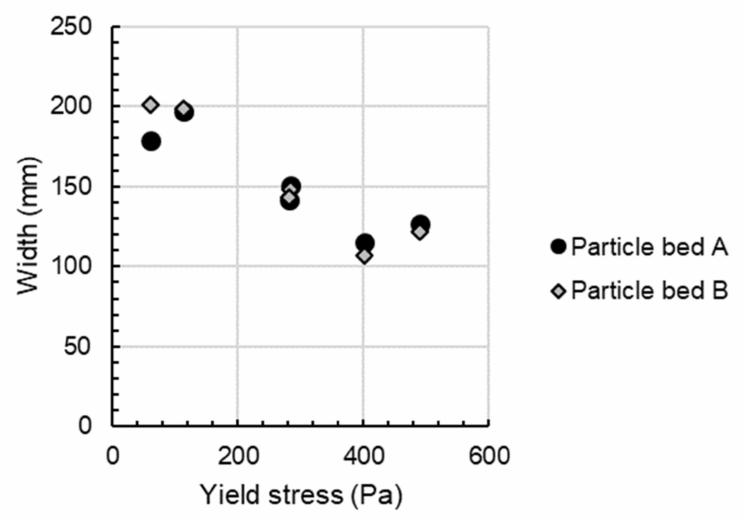
Figure 6. An increase in yield stress correlates with a decrease in strand width for particle bed A and B.